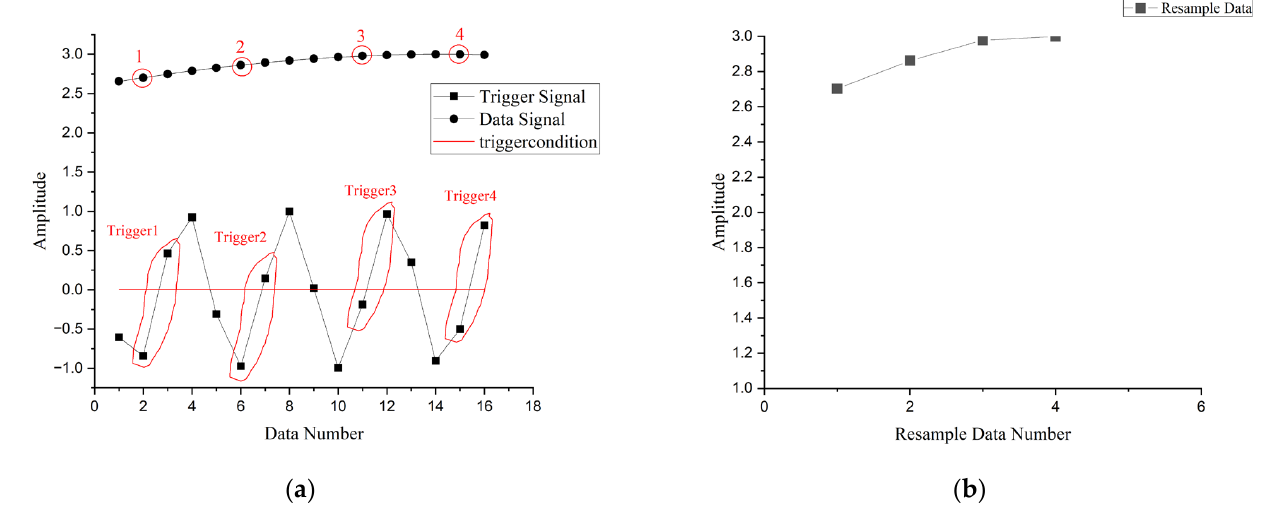
Figure 5. ( a ) Trigger resampling schematic; ( b ) Resampling data splicing schematic.